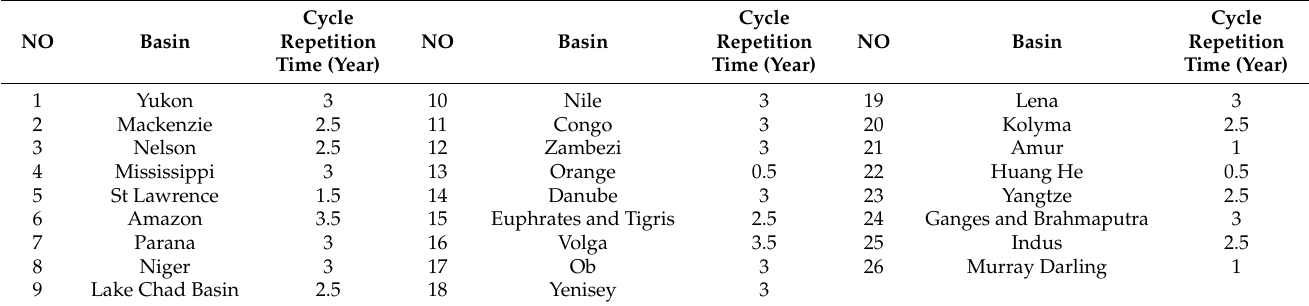
Table 16. Statistical table of cycle repetition time of 26 basins (December 2012 to June